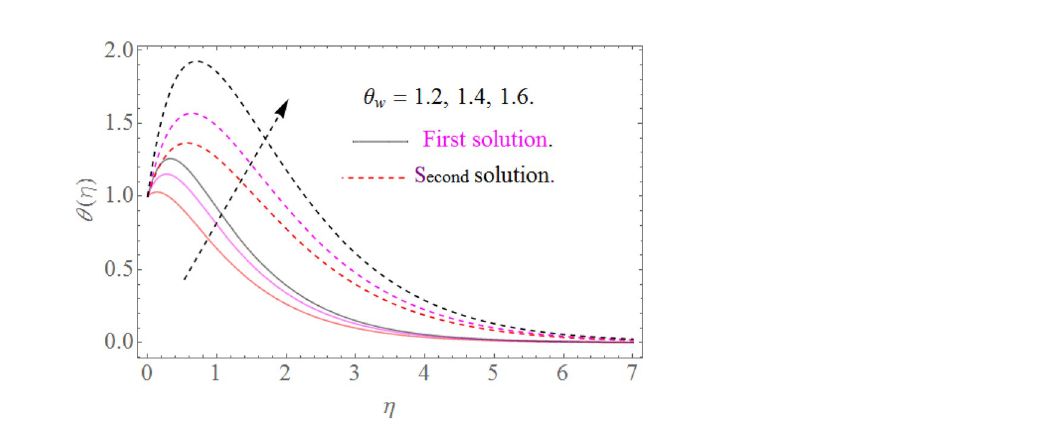
Figure 10. Impact of θ w on θ(η) for R = 0.3, Pr = 10.2